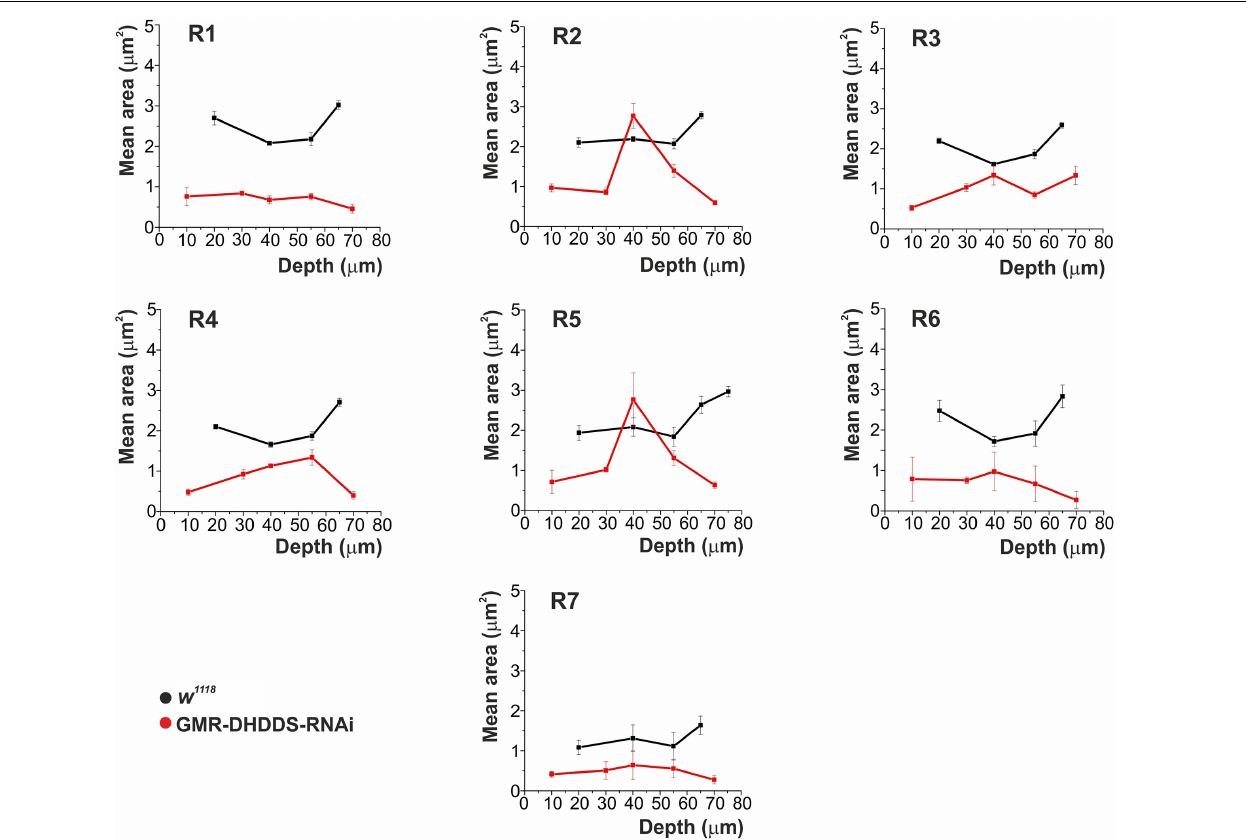
FIGURE 4 | The mean cross-section area of rhabdomeric slices measured from R1-7 photoreceptors as a function of retinal depth. Analysis of serial TEM retinal cross sections of newly eclosed flies. Four sections were analyzed for the control group ( w 1118 ), at the depths of 20, 40, 55, and 65 µ m from corneal surface. Six sections were analyzed for the experimental group (GMR-DHDDS-RNAi), at the depths of 10, 30, 40, 55, 70, and 85 µ m from corneal surface. For each depth, 4–19 ommatidia were analyzed. The values in the graphs represent the mean area (in µ m 2 ) of every R1–7 rhabdomere, as a function of depth, ± STDEV (Standart deviation). Measurements were done using the ImageJ and Origin softwares. A comparison was performed between the mean area of R2 or R5 at the retinal depth of 40 µ m and the mean area of R1 , serving as a representative rhabdomere from the group of R1, R3, R4, and R6, at the same retinal depth. While the mean area of R2 and R5 at 40 µ m was 2.1 ± 0.4 and 2.4 ± 0.5 µ m 2 , respectively, the mean area of R1 at the same depth was 0.6 ± 0.1 µ m 2 (average ± SEM, n = 6 for each group) and the differences between the groups were significant p ≤ 0.01 (**) for the difference between R2 and R1 , and p ≤ 0.05 for the difference between R5 and R1 (a two tailed, unpaired student’s t -test). At all other depths, R2 and R5 of GMR-DHDDS-RNAi retinal sections exhibited similar areas in comparison to R1 , R3 , R4 , and R6 . Note the smaller cross section area of all rhabdomeres of GMR-DHDDS-RNAi flies (red) relative to the w 1118 control flies (black) at all measured retinal depth except for R2 and R5 rhabdomeres at ∼ 40 µ m depth, where cross-section areas were similar to that of w 1118 flies. The cell nucleus resides at ∼ 40 µ m depth from the corneal surface.